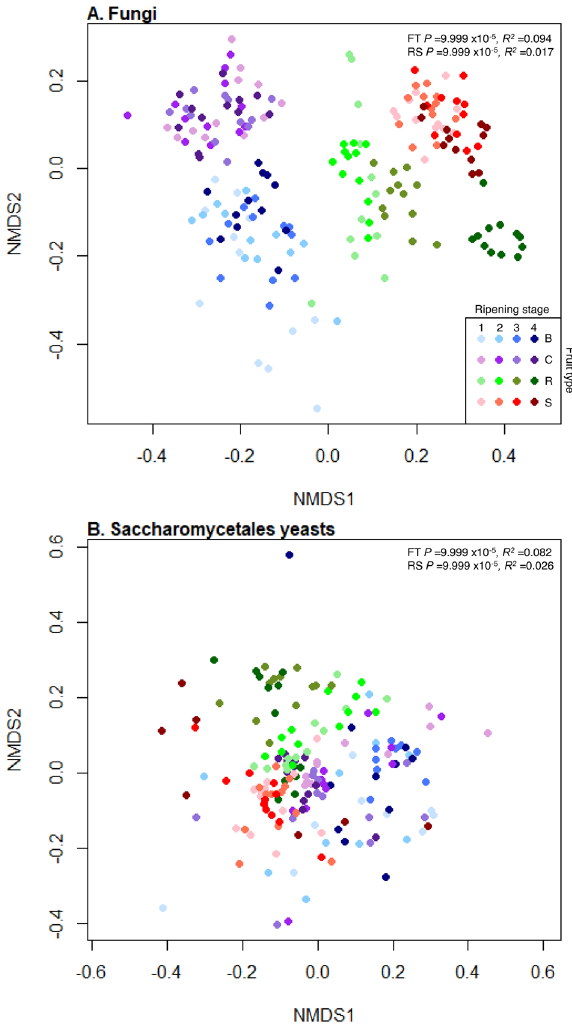
Figure 3. NMDS plots representing the differential presences of fungal phylotypes. Nonmetric Multidimensional Scaling (NMDS) plots of binary Jaccard measures of community dissimilarity of ( A ) total fungal communities and ( B ) Saccharomycetales budding yeasts on blueberry (blue), cherry (purple), raspberry (green) and strawberry (red) at four ripening stages (1, unripe/green fruit; 2, de-greening fruit; 3, ripening fruit; and 4, fully ripe/harvest fruit; denoted by shade of colour, lightest shade for green fruit and moving through to darkest shade for fully ripe/harvest). Both total fungal and Saccharomycetales yeasts communities significantly differ in the presences of phylotypes across all fruit types (FT) and ripening stages (RS) by PermANOVA (values shown top